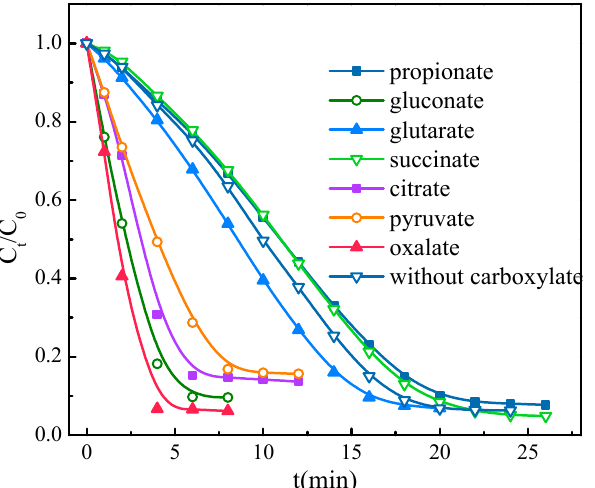
Figure 2. The effects of different carboxylates on the decolorization of Orange ([Fe 3+ ] 0 = 100 µM, [Orange II] 0 = 50 µM, [PMS] 0 = 150 µM, [carboxylates] 0 = 80 µM, under UVA irradiation, λ irr. = 365 nm, pH = 3).